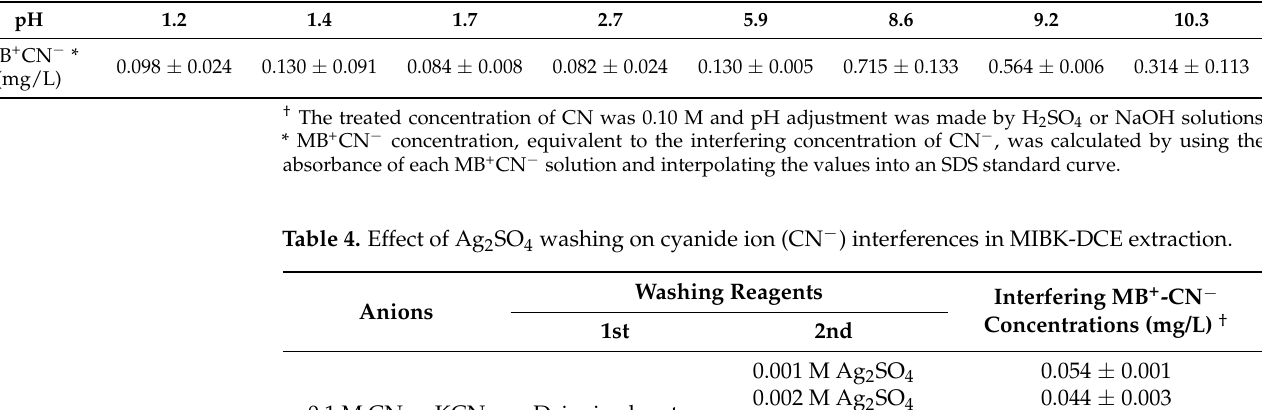
Table 3. Effect of pH on cyanide ion (CN − ) interferences in MIBK-DCE extraction † .